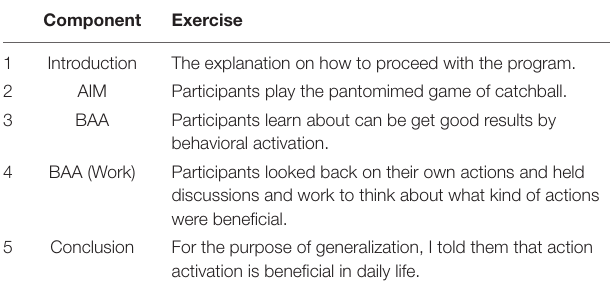
TABLE 1 | Summary of the intervention program for AIM + BAA